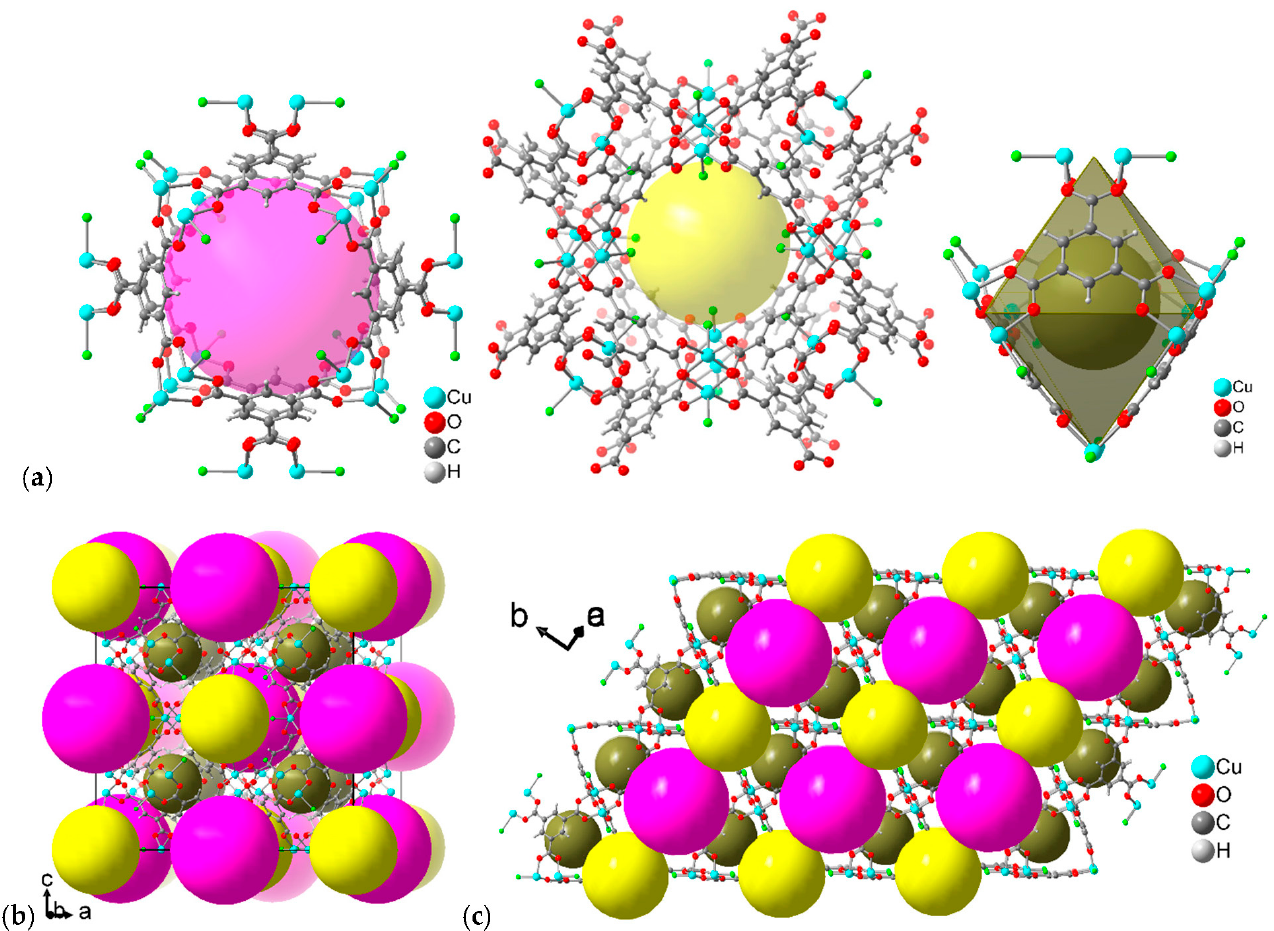
Figure 2. ( a ) Large (pink), medium (yellow) and small (dark yellow) pores in HKUST-1 with the surrounding framework (the three objects are not drawn to scale). The green atoms on Cu depict the aqua ligands. ( b , c ) Packing diagrams of HKUST-1 with the three different pores and ( b ) the c axis. i.e., [001] direction vertical, ( c ) the abc diagonal, i.e., [111] direction vertical. Structures were drawn with the program DIAMOND [48] using the cif file with CCDC Refcode FIQCEN [19] from the Cambridge Crystallographic Data Center, CCDC.